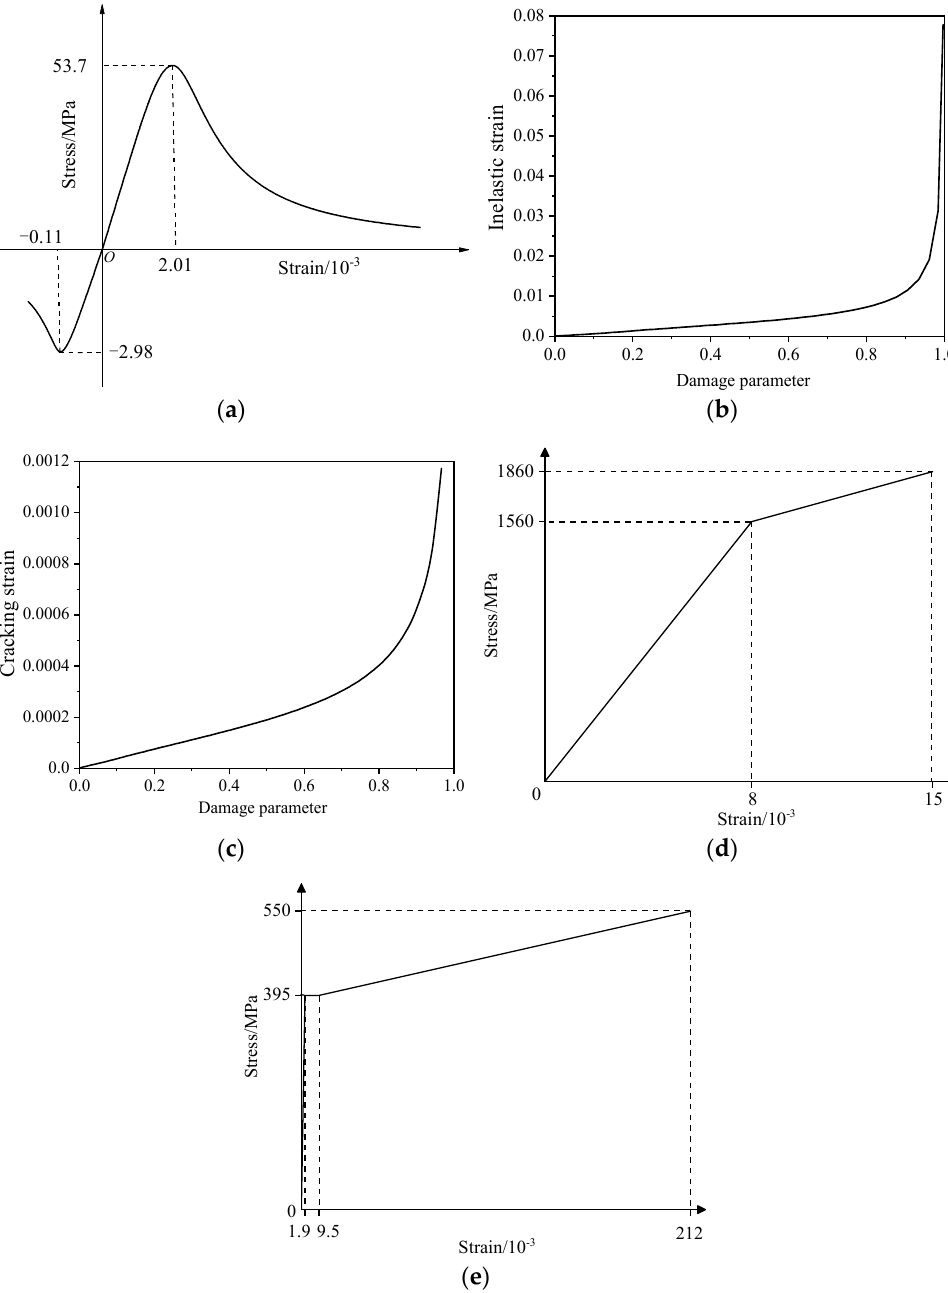
Figure 9. Constitutive curves of the finite element model. ( a ) Stress vs. strain of concrete; ( b ) Com- pression damage of concrete; ( c ) Tension damage of concrete; ( d ) Stress vs. strain of the pretensioned strands; ( e ) Stress vs. strain of steel bars.